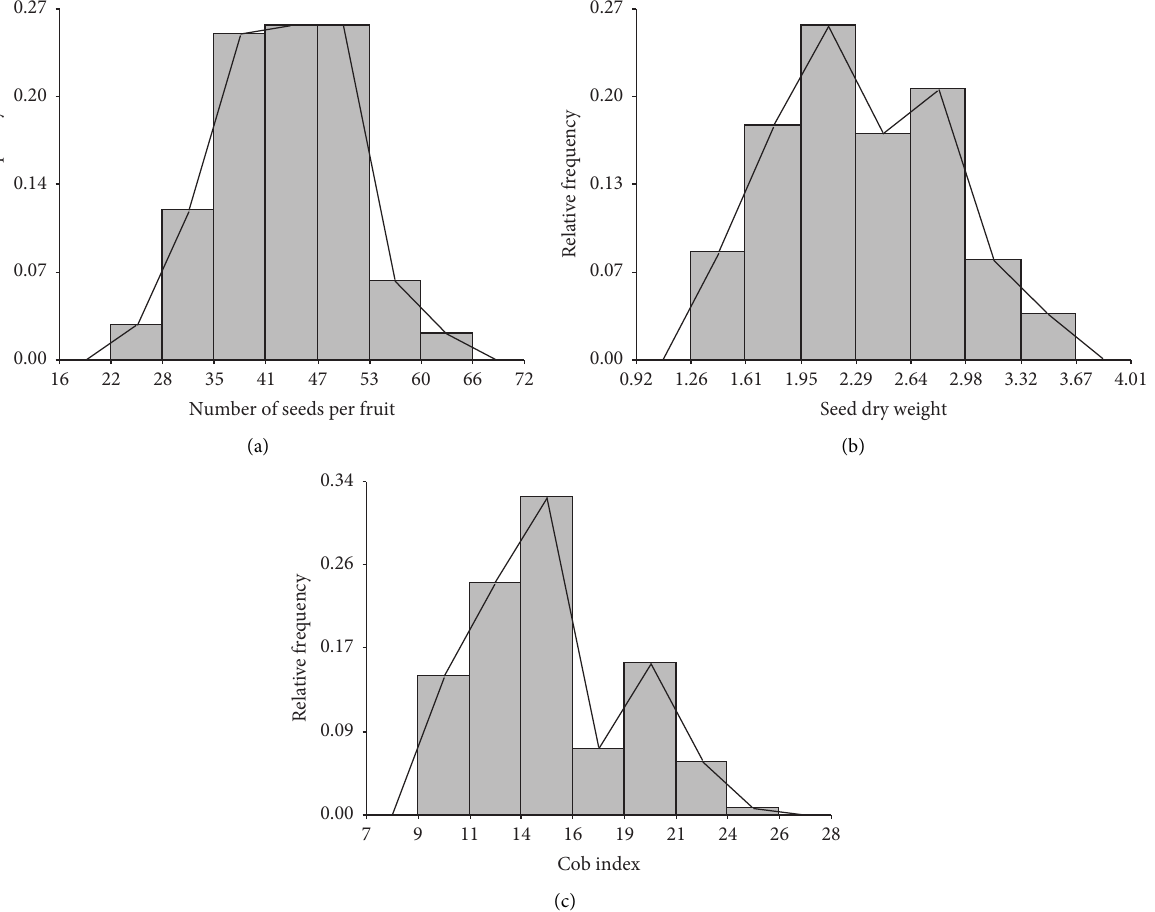
Figure 9: Histograms of the productivity characteristics of FFNC ecotypes. (a) Number of seeds per fruit. (b) Dry peeled seed weight. (c) Index of cocoa fruits.